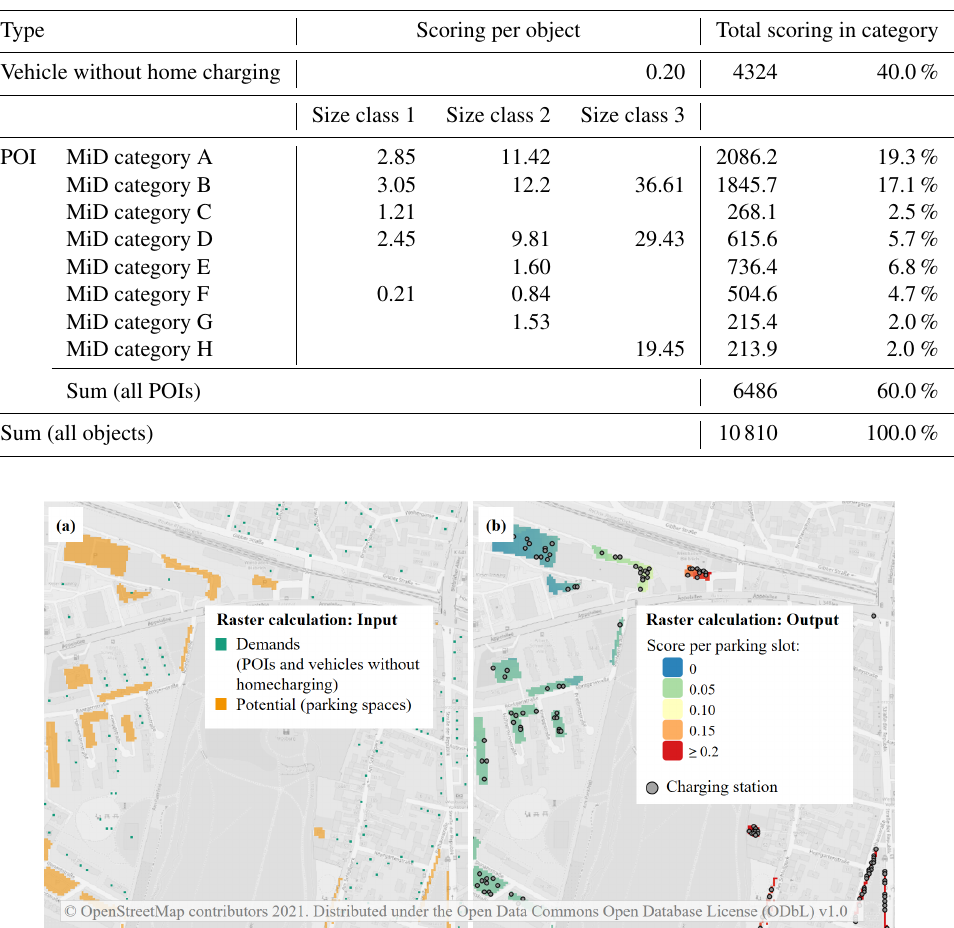
Figure 2. Raster calculation: Inputs (a) and outputs (b) .